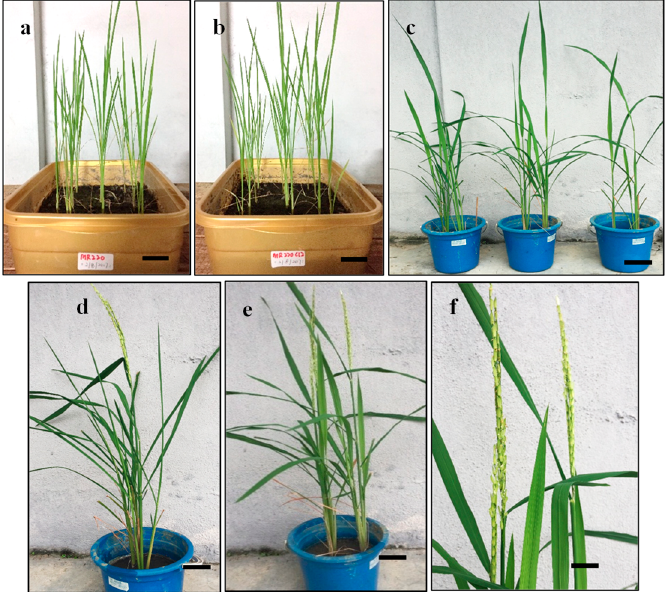
Figure 10. The plantlets of MR220 ( a , d , e , f ) and MR220-CL2 ( b , c ). ( a , b ) The plantlets were growing in the soil after 2 weeks of acclimation. ( c ) The regenerated plants in the pot after 5 weeks. ( d , e ) The plant started to flower. ( f ) The grain filling stage of the plant (Bar = 1